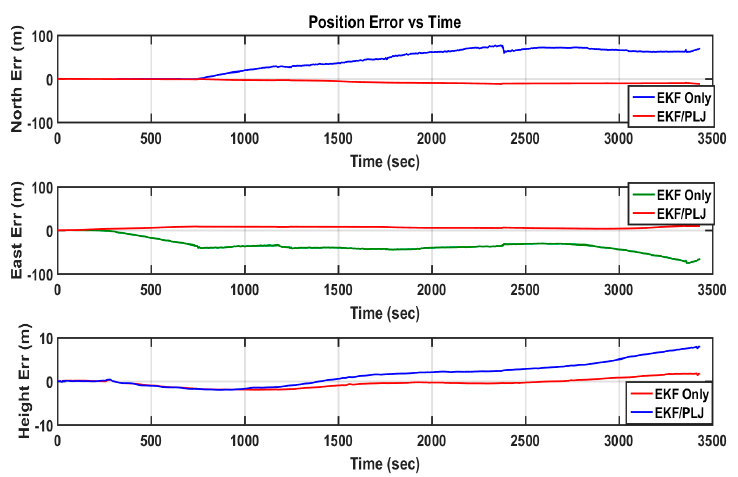
Figure 15. Trajectories—Scenario #2.